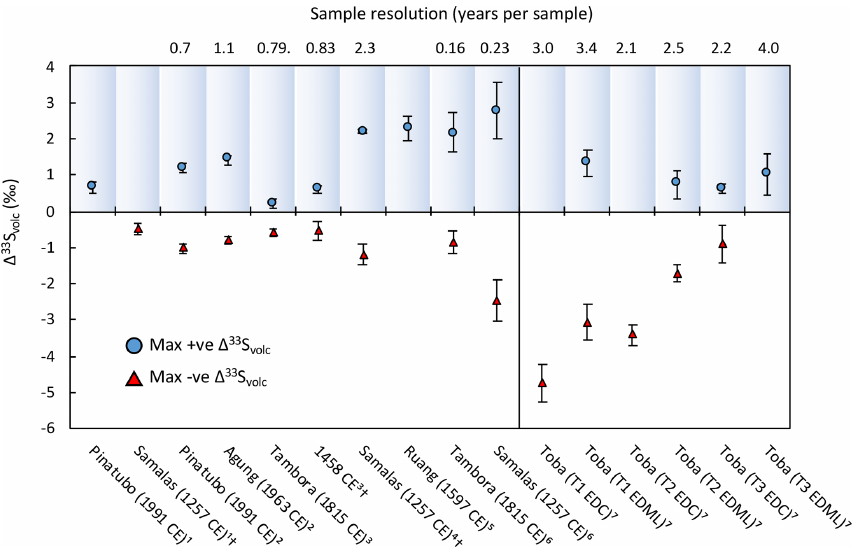
Figure 5. Comparison between (cid:49) 33 S volc measured for volcanic events in this study and the largest volcanic S-MIF from previous studies of historical eruptions. Where available we have also included the sample resolution. Data sources are as follows: (1) Savarino et al. (2003), (2) Baroni et al. (2007), (3) Cole-Dai et al. (2009), (4) Gautier et al. (2018), (5) Gautier et al. (2019), (6) Burke et al. (2019), (7) This study. † These dates are taken from Sigl et al.